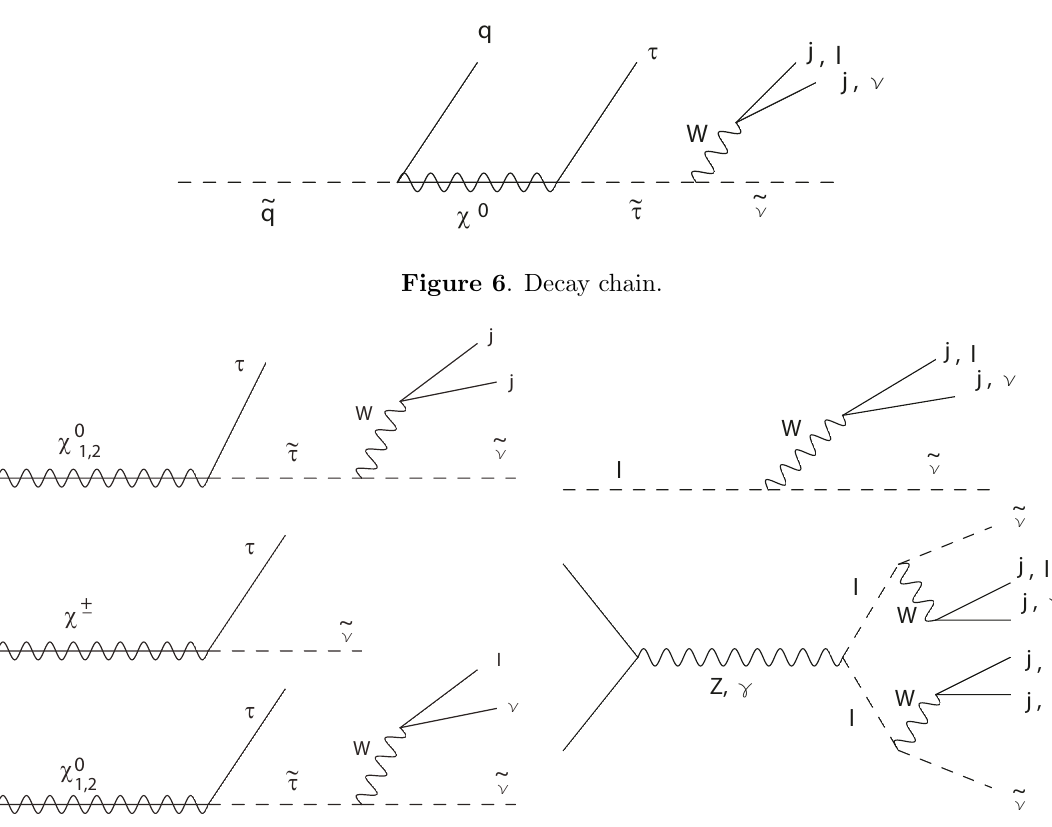
Figure 7 . Typical heavy and light (cid:13)avor squark decay chains in an Antisplit